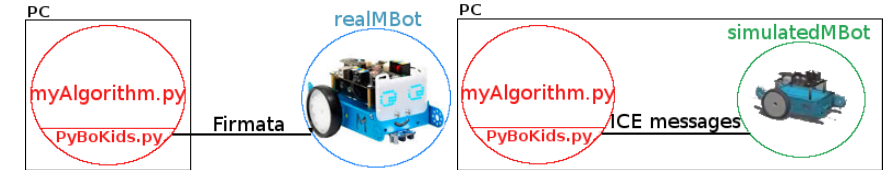
Figure 2. Connection of the PyBoKids.py library with the real mBot and the simulated mBot.